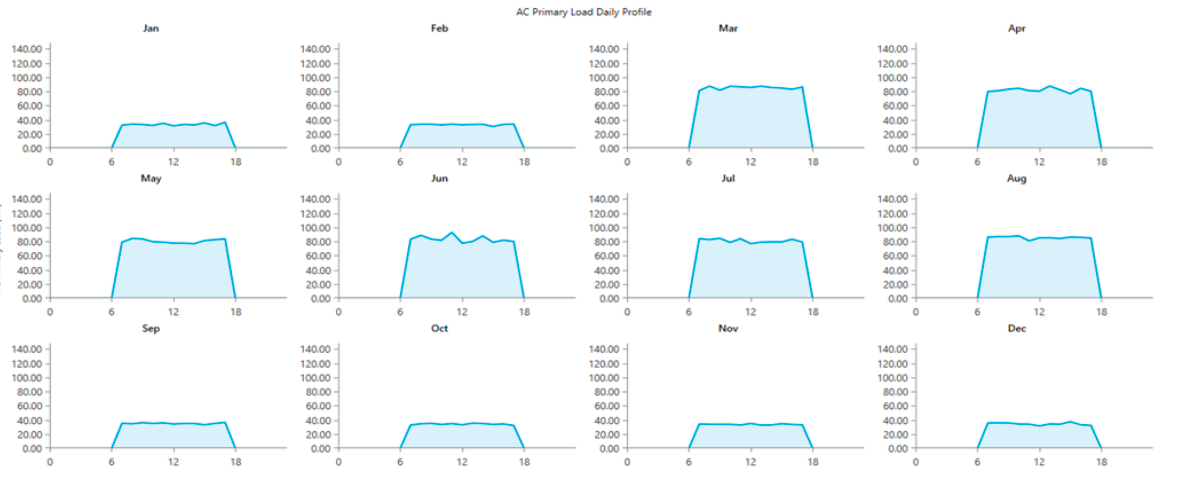
Figure 11. Site load profile for one year.